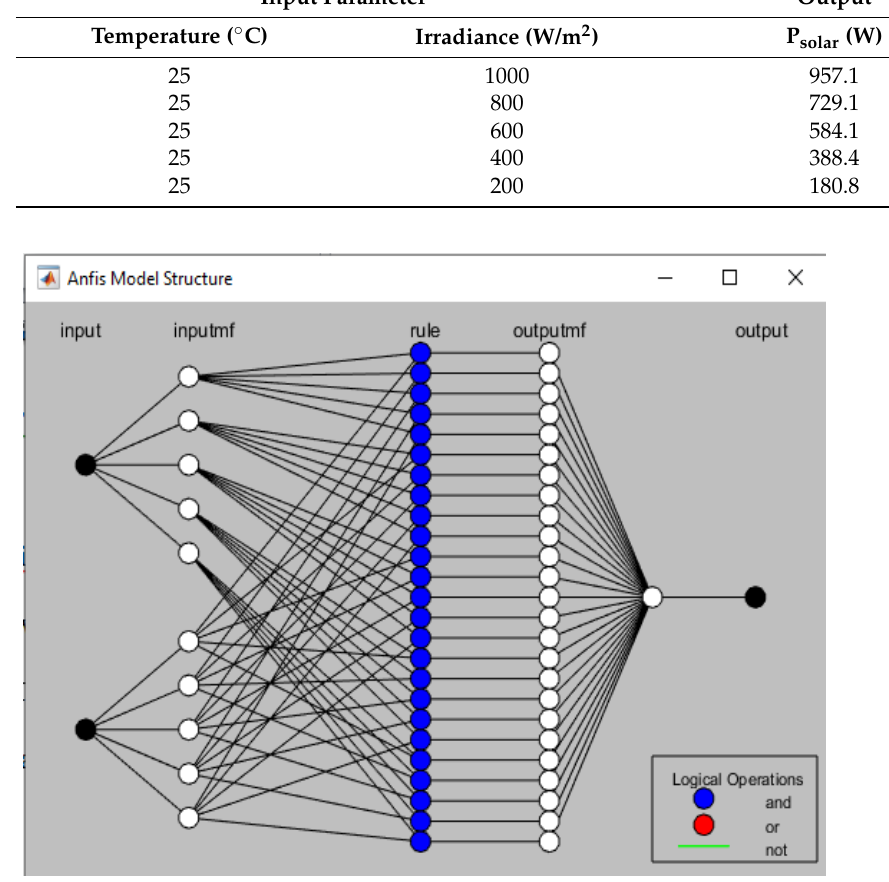
Figure 4. ANFIS network structure for P solar .